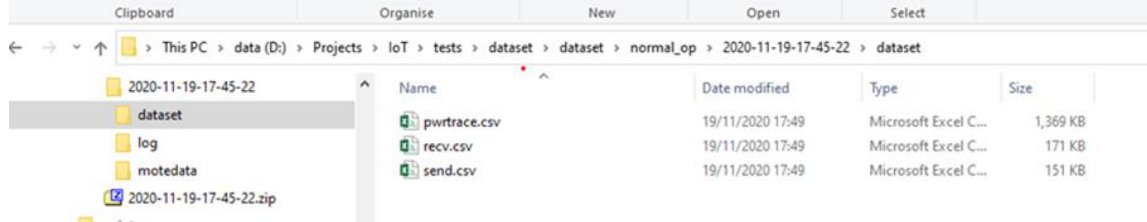
Figure 9. Location of the generated “pwrtrace.csv”, “recv.csv”, and “send.csv” files by the “IoT_Simul.sh” file .